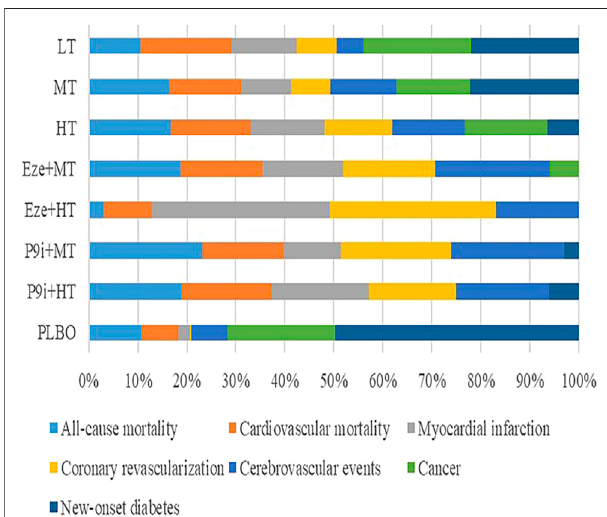
FIGURE 2 | Rankogram showing the probability analysis of clinical outcomes included among the interventions. LT, low-intensity statins; MT, moderate-intensity statins; HT, high-intensity statins; Eze+MT, ezetimibe + moderate-intensity statins; Eze+HT, ezetimibe + high-intensity statins; P9i+MT, PCSK9i + moderate-intensity statins; P9i+HT, PCSK9i + high- intensity statins; PLBO, placebo.